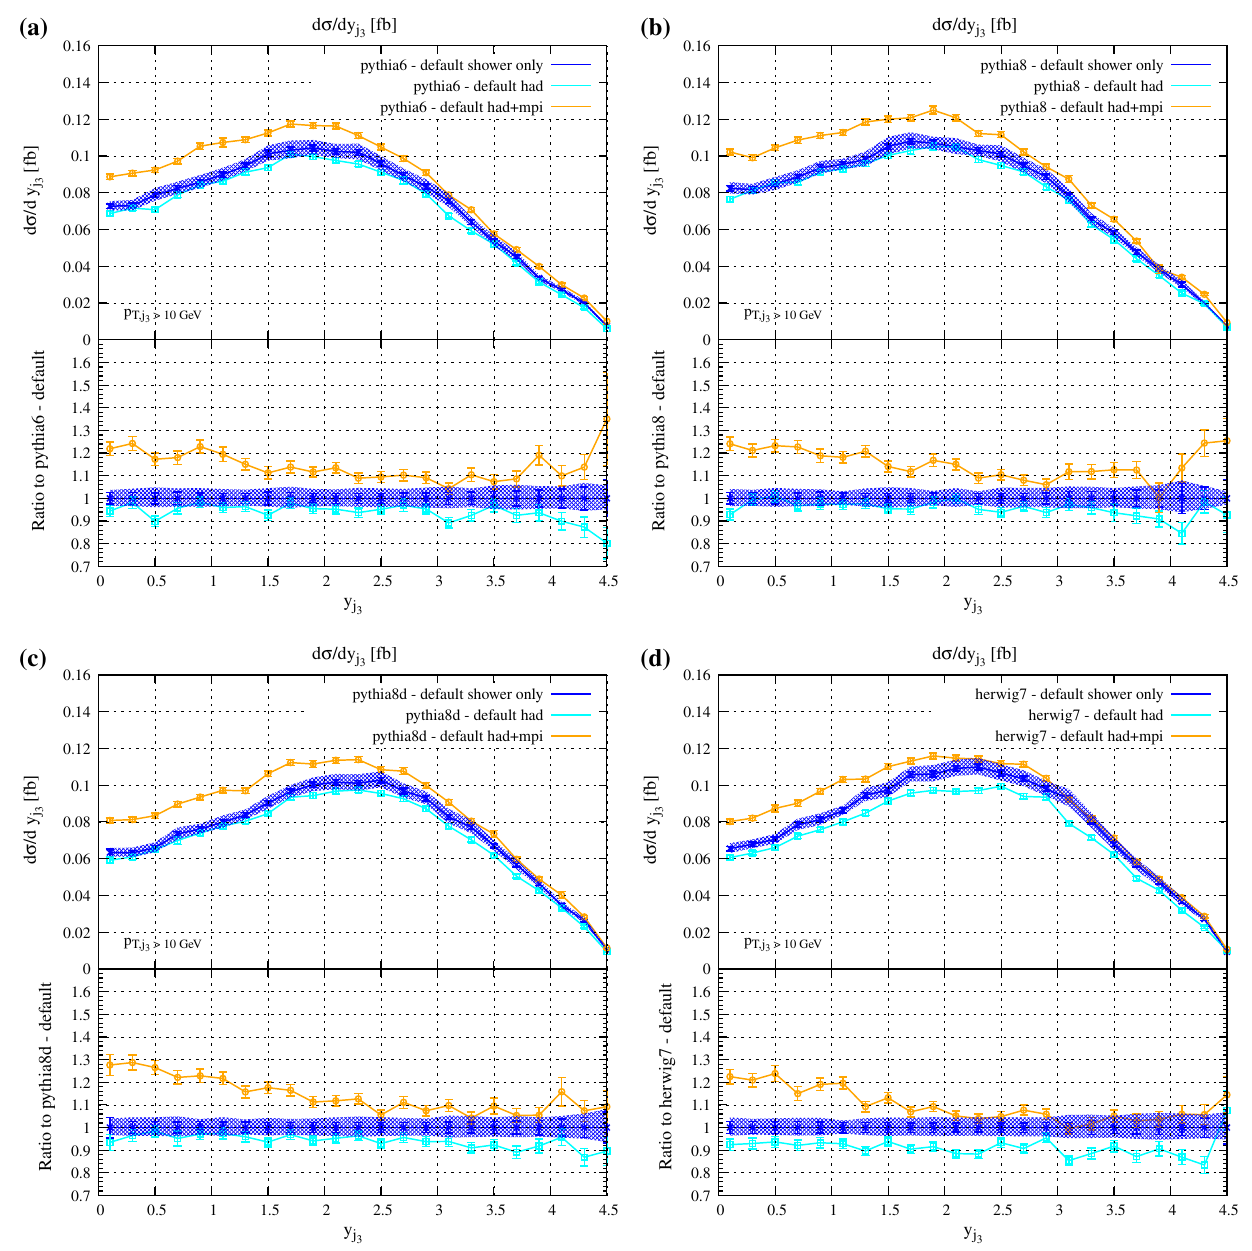
Fig. 10 Rapidity distribution of the third jet in the ATLAS-loose sce- nario for different SMC settings [blue: parton shower only, cyan: par- ton shower with hadronization, orange: parton shower with hadroniza- tion and multi-parton interactions]. The same observable is shown for PYTHIA6 ( a ), PYTHIA8 withrecoilshower( b ), PYTHIA8 withdipole